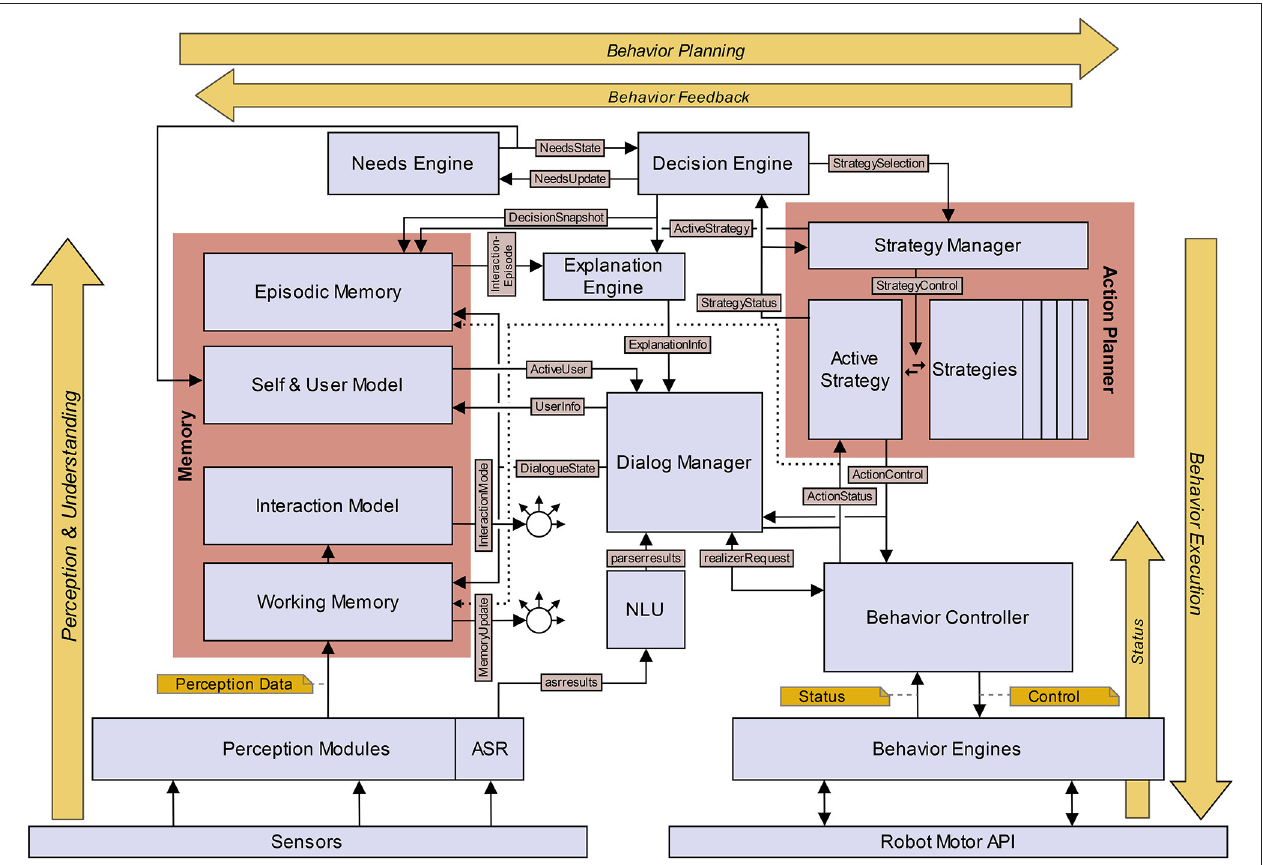
FIGURE 4 | Schematic view of the explainable interaction architecture for an autonomous self-explaining social robot. The components are marked using rectangles and the most important communication interfaces between components are indicated by black arrows. Dotted arrows are used to enhance readability and have the same meaning as solid